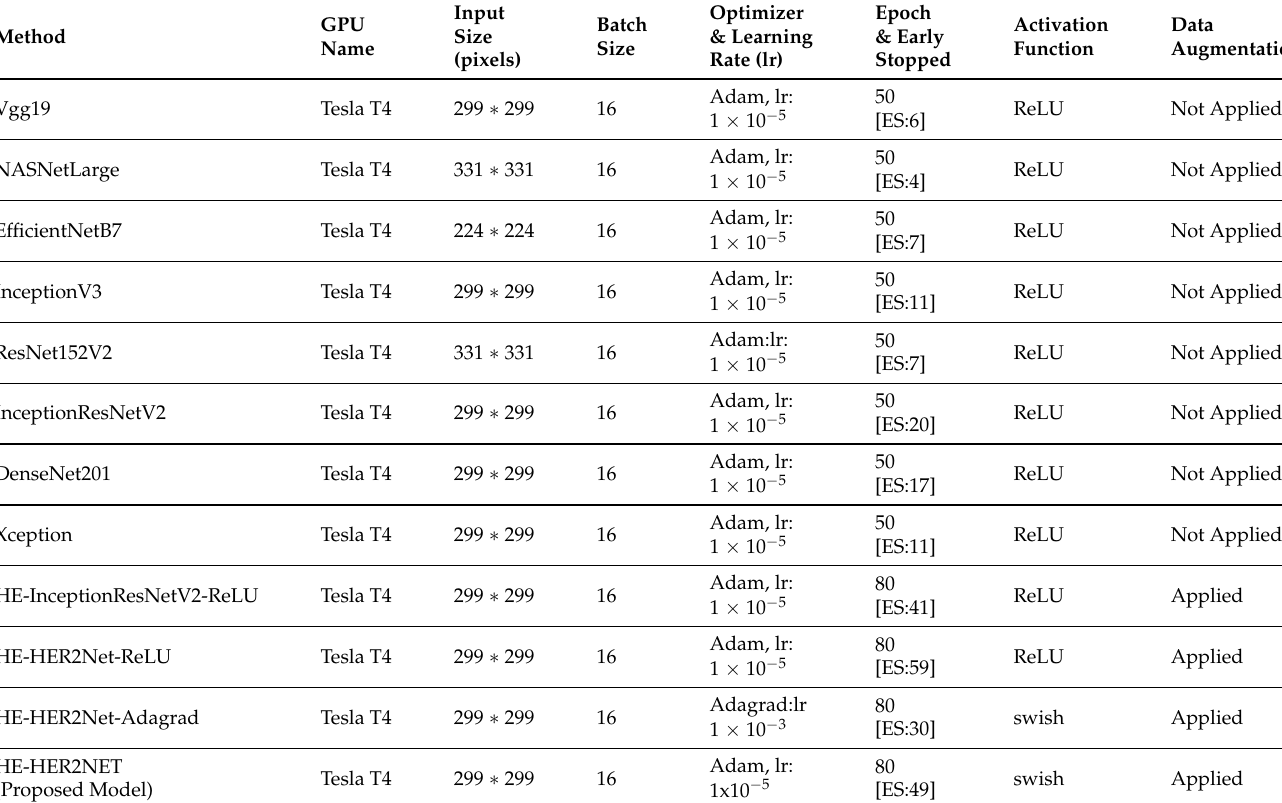
Table 1. This table describes the summary of the environmental